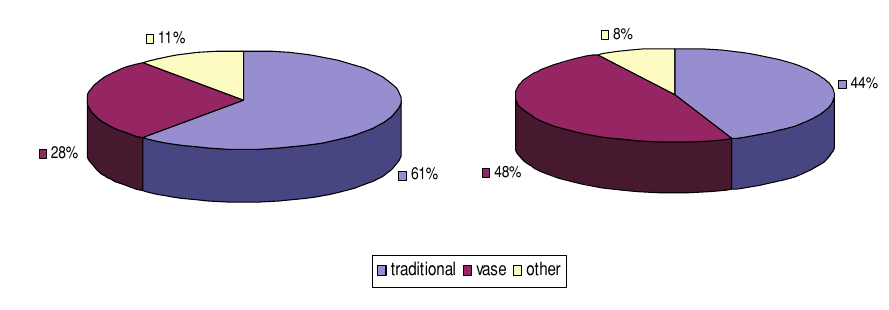
Source: Own figure based on CSO Figure 10: The cultivation methods in sour cherry orchards in South Transdanubia and Northern Hungary